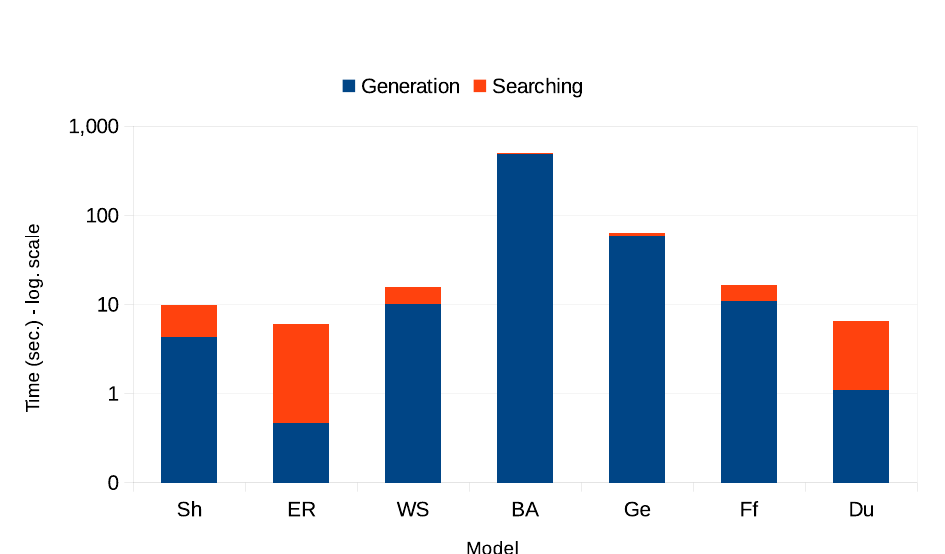
Figure 10. Running times for generating random networks and searching the feed forward loop on Mus musculus with no labels according to Shuffling (Sh), Erdos-Renyi (ER), Watts-Strogatz (WS), Barabasi-Albert (BA), Geometric (Ge), Forest Fire (Ff) and Duplication (Du)